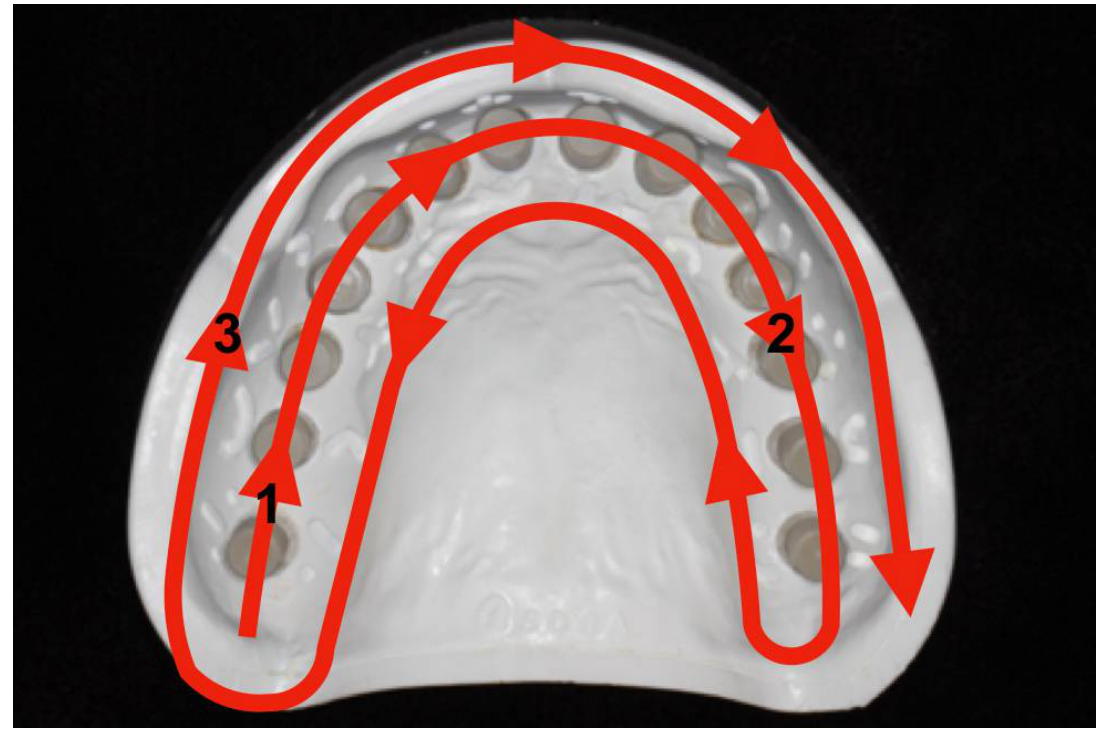
Figure 3. Scanning sequence for digital impression of the master model.